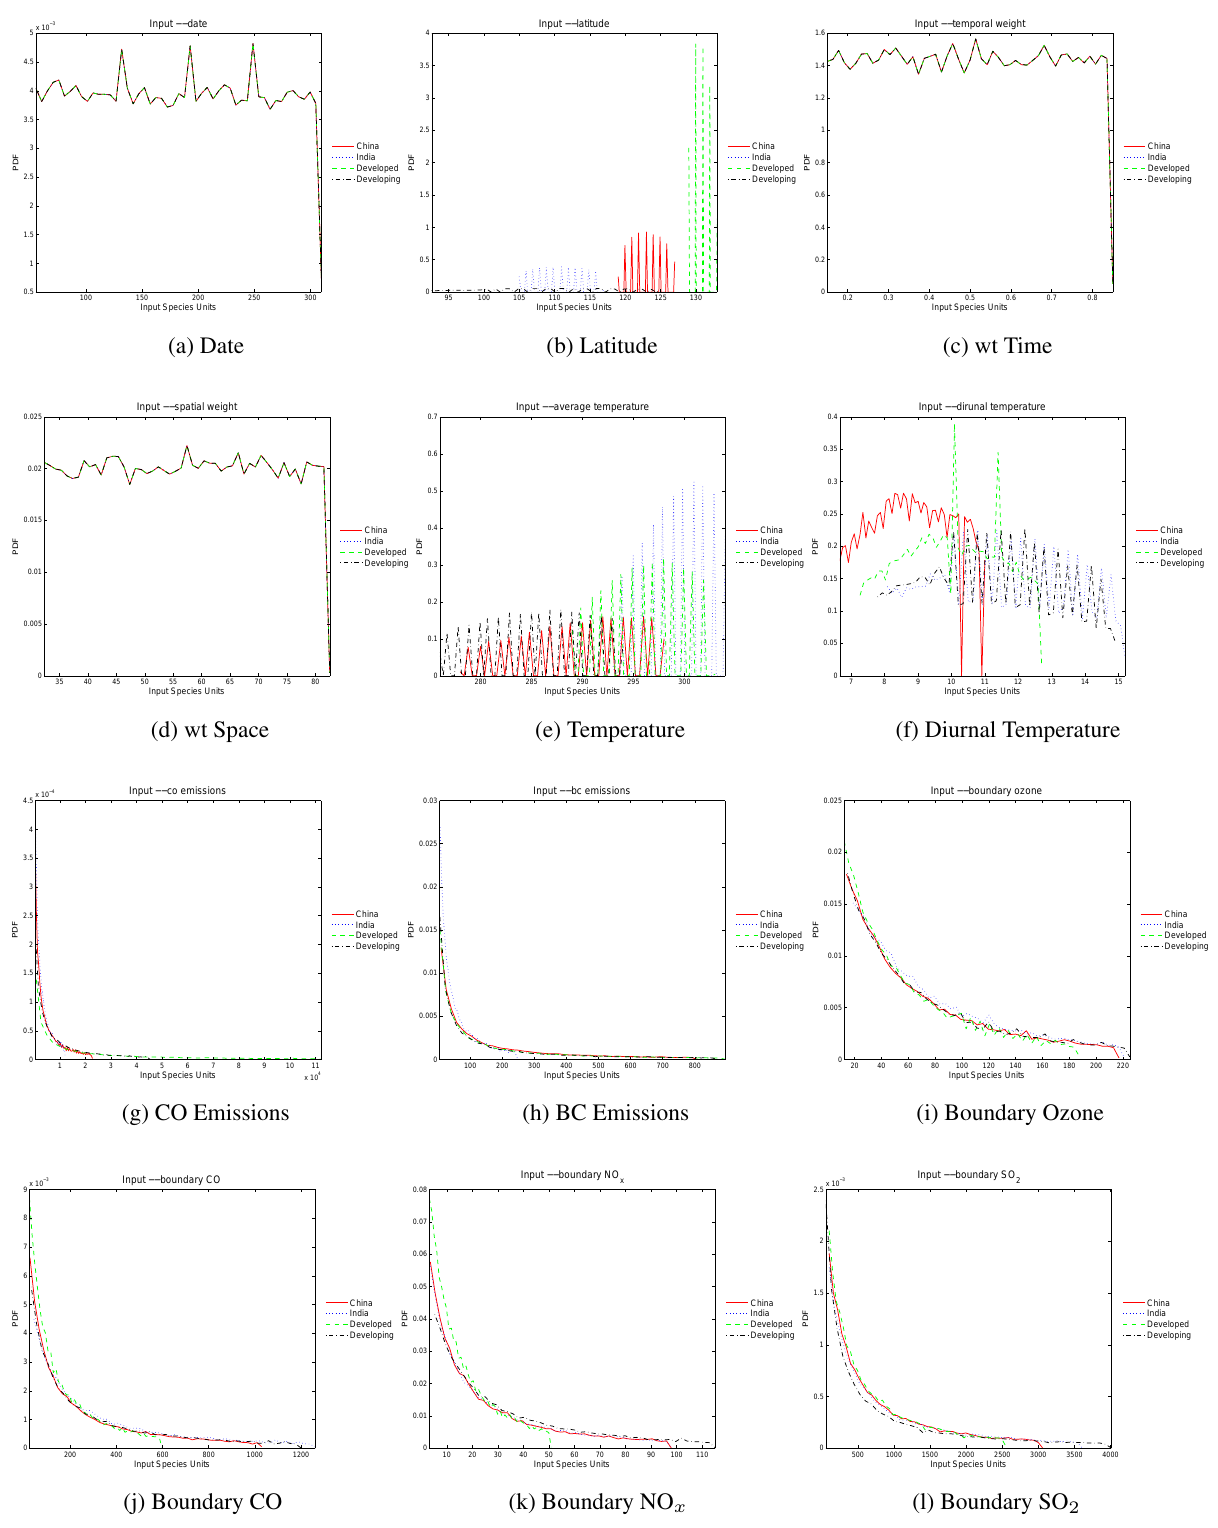
Fig. 5. These are the PDFs of 12 of the 13 required input species for 50000 runs of the metamodel. Each input was randomly chosen to correspond to the inverse CDF of each PDF in the range from 0.15 through 0.85. The underlying PDFs, their units, and their best fit parameters are defined in Table 3. The reason that isoprene is not included is because it is the same as the underlying PDF given in Fig. 1.